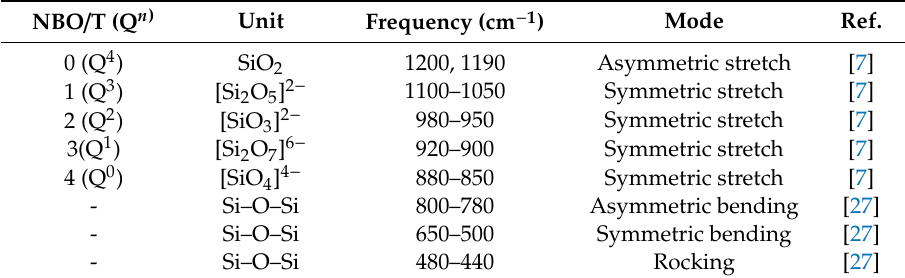
Table 2. FTIR / Raman shift with vibration mode for di ff erent silicate structure units.